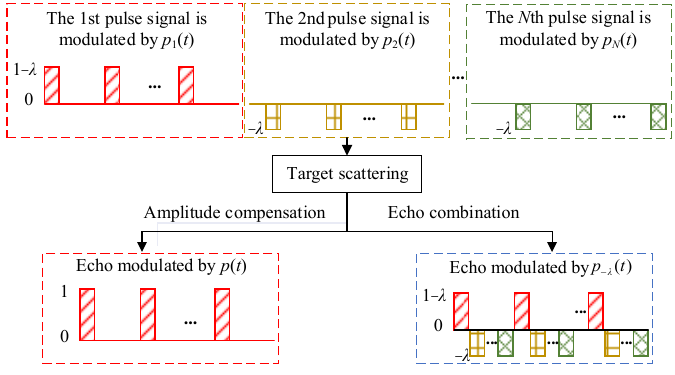
Figure 3. Amplitude modulation design of pulse signal.